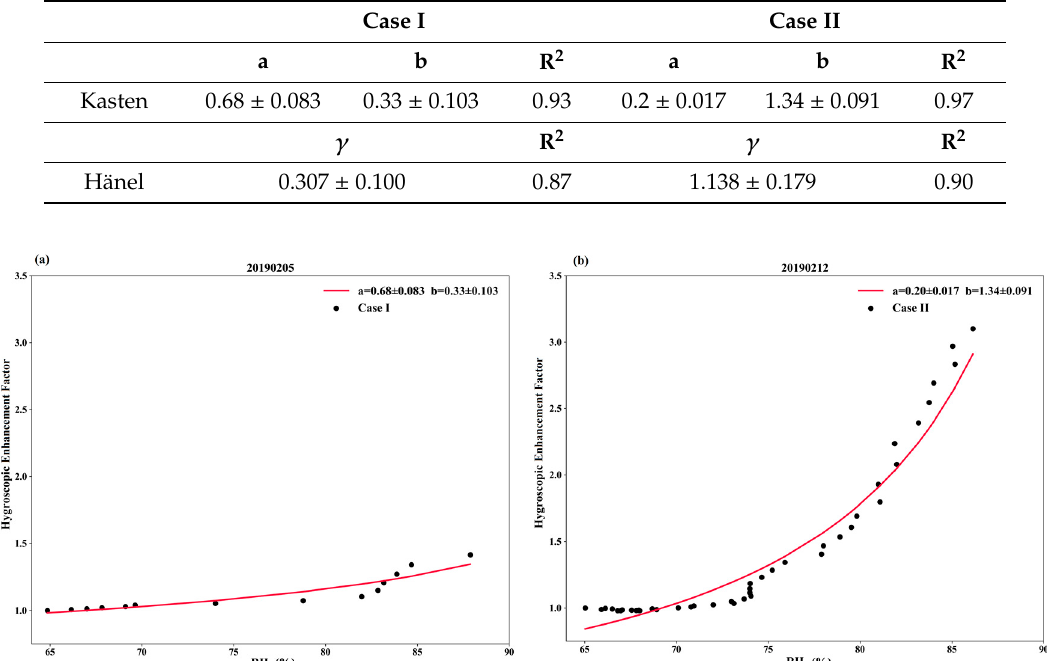
Table 4. The fitting parameters and coe ffi cients of determination (R 2 ) of the fits using the Kasten and Hänel models.